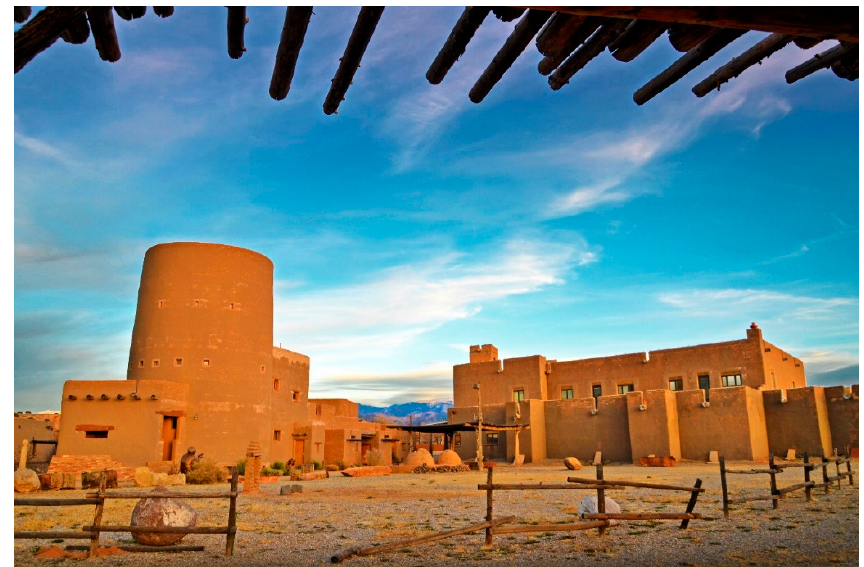
Figure 1. The Poeh Cultural Center, Pojoaque Pueblo, New Mexico. Used by permission of the Poeh Cultural Center.